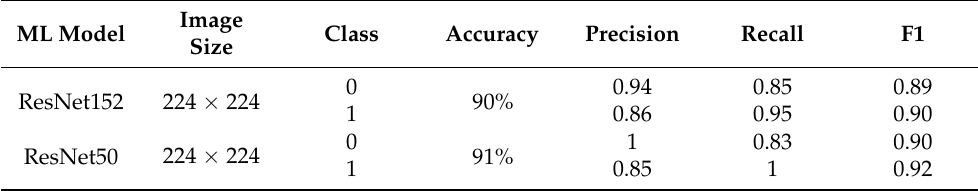
Table 4. Classification results obtained on the tested